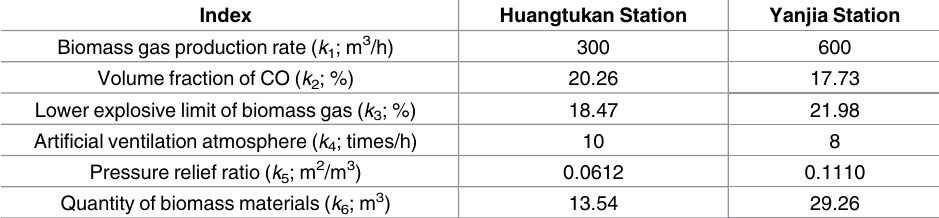
Table 6. Index data of Huangtukan station and Yanjia station.